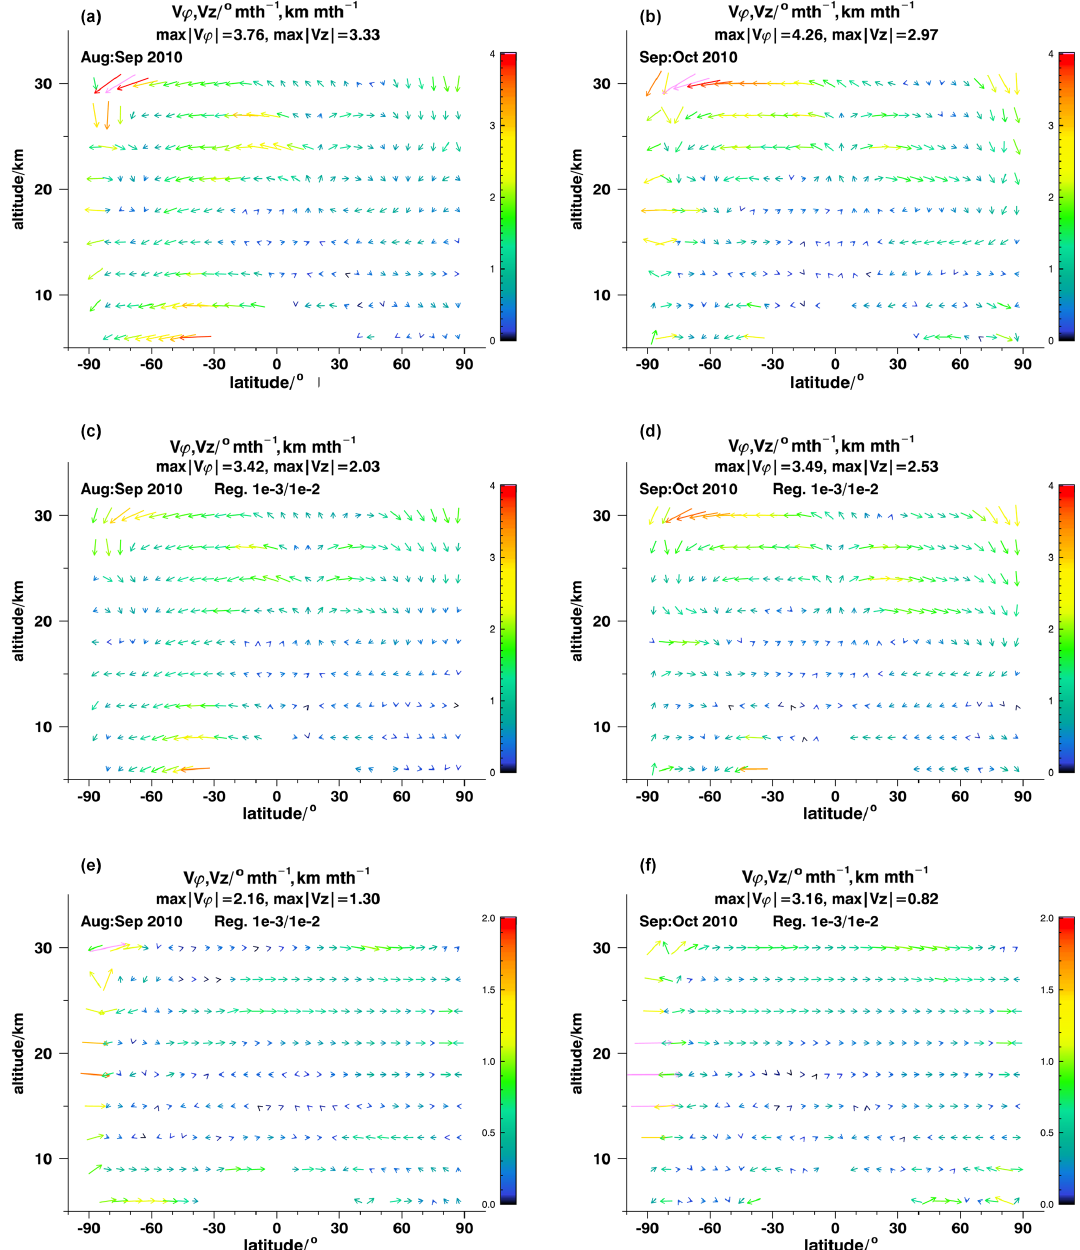
Figure 6. As for Fig. 4 but with a reduced altitude range for clearer representation of lower